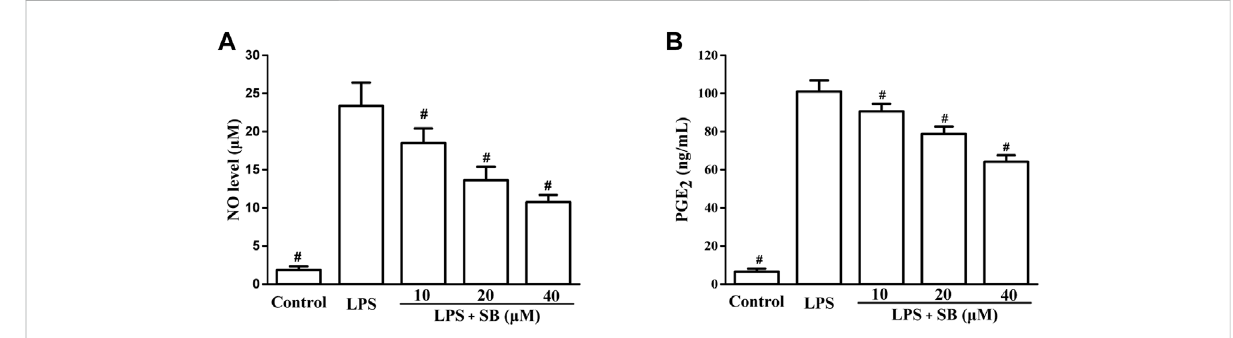
FIGURE 3 SB treatment reduced LPS-induced NO (A) and PGE 2 (B) in hPDLs. # p < 0.05, compared to the LPS group.